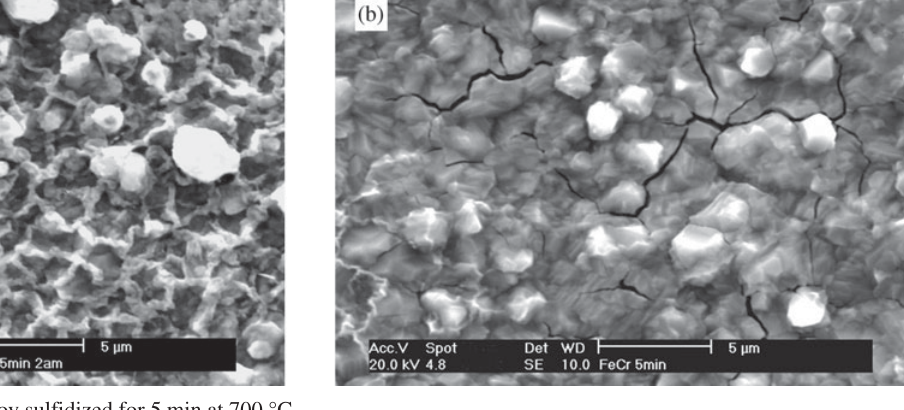
Figure 7. Surface of the FeCr alloy sulfidized for 5 min at 700 °C.